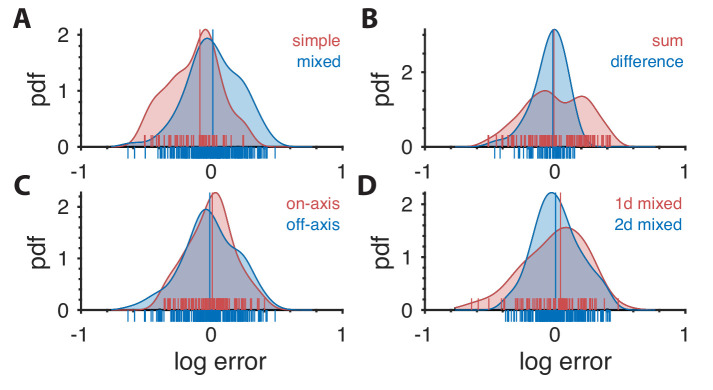
Distribution of prediction errors across specific subsets of thresholds.Each plot shows kernel-density estimates of the distribution of log prediction errors (defined as difference between log prediction and log measurement) after splitting the data into the subgroups indicated at the top right of each plot. Individual data points are shown on the abscissa. The median log prediction error is shown for each group in the corresponding color. (A) Predictions tend to underestimate thresholds in simple planes and overestimate thresholds in mixed planes (p=0.0014, Kolmogorov-Smirnov (K–S) test). As a reminder, the natural-image analysis predicts thresholds only up to a multiplicative factor, which is chosen in a way that makes the mean log prediction error over all second-order thresholds be zero. (B) Predictions tend to have greater error in planes defined by modular sums (such as the simple plane β++ or the mixed plane (β++[0],β++[1])) than in planes defined by modular differences (such as the simple plane β+− or the mixed plane (β+−[1],β+−[0])) (p=1.8⋅10-4, K-S test). However, thresholds in neither subgroup are systematically over- or under-estimated. (C) There is no significant difference in predictions in on-axis directions (directions parallel to an axis in a simple or mixed coordinate plane), vs. all other (off-axis) directions (p=0.56, K-S test). (D) Thresholds are more accurately predicted for ‘2-D’ correlations than ‘1-D’ correlations. A mixed plane like (β++[0],β+−[0]) involves the same pair of checks in both directions, thus leading to correlations that are in a sense 1-D. In contrast, the mixed plane (β++[1],β+−[0]) involves the three checks A1, A2, and A3, leading to 2-D correlations. While the medians of the errors in these two subgroups are similar (KS test p=0.25; Wilcoxon rank-sum test p=0.96, medians 0.042 vs. 0.004, respectively), prediction error magnitude is lower for 2-D correlations (p=0.01, KS-test on absolute log errors).